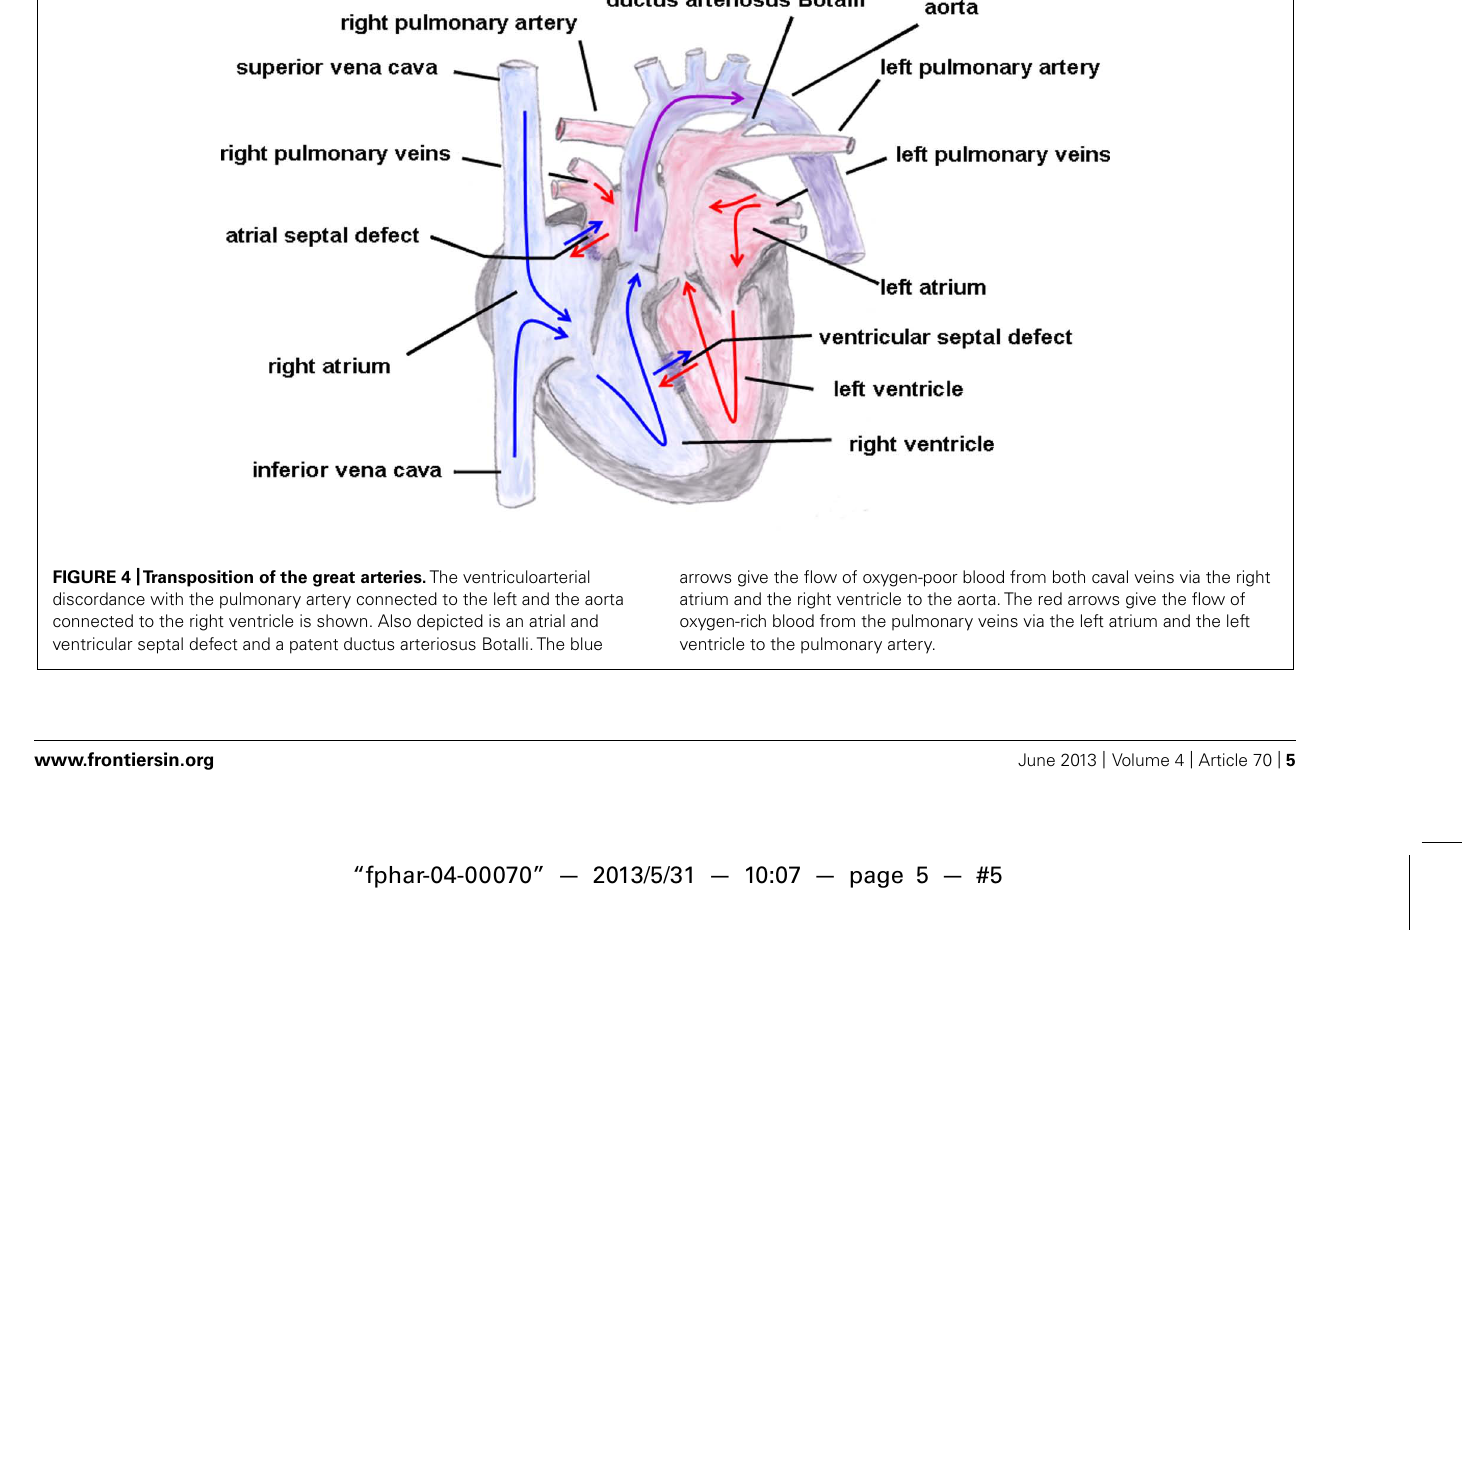
FIGURE 4 |Transposition of the great arteries. The ventriculoarterial discordance with the pulmonary artery connected to the left and the aorta connected to the right ventricle is shown. Also depicted is an atrial and ventricular septal defect and a patent ductus arteriosus Botalli.The blue